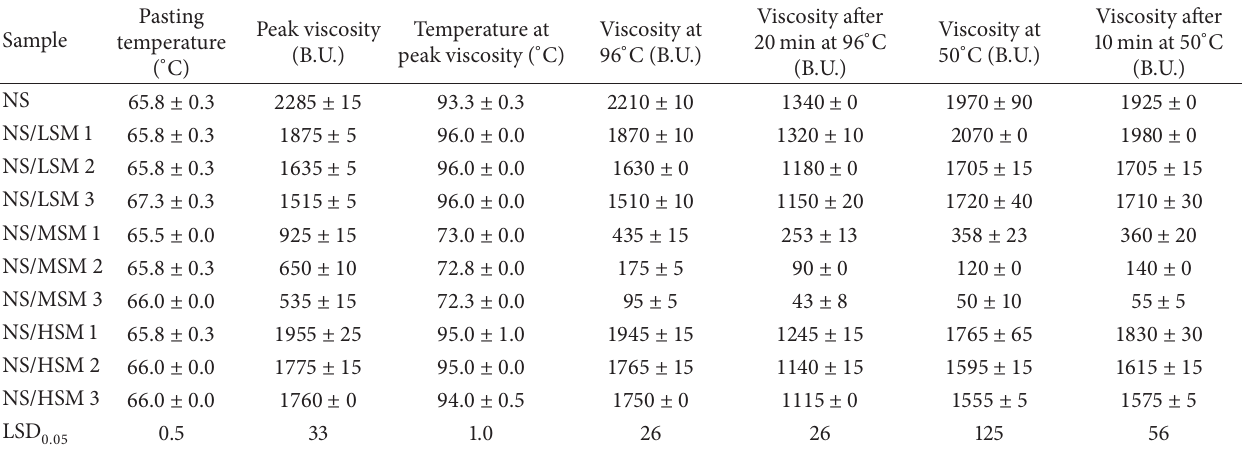
Table 1: Pasting characteristics of native starch and blends with